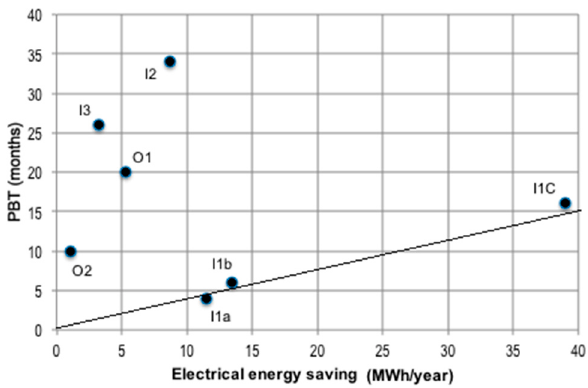
Figure 8. PBT values (months) vs. electrical energy saving (MWh/year) for the seven analysed interventions on the indoor and outdoor lighting systems.